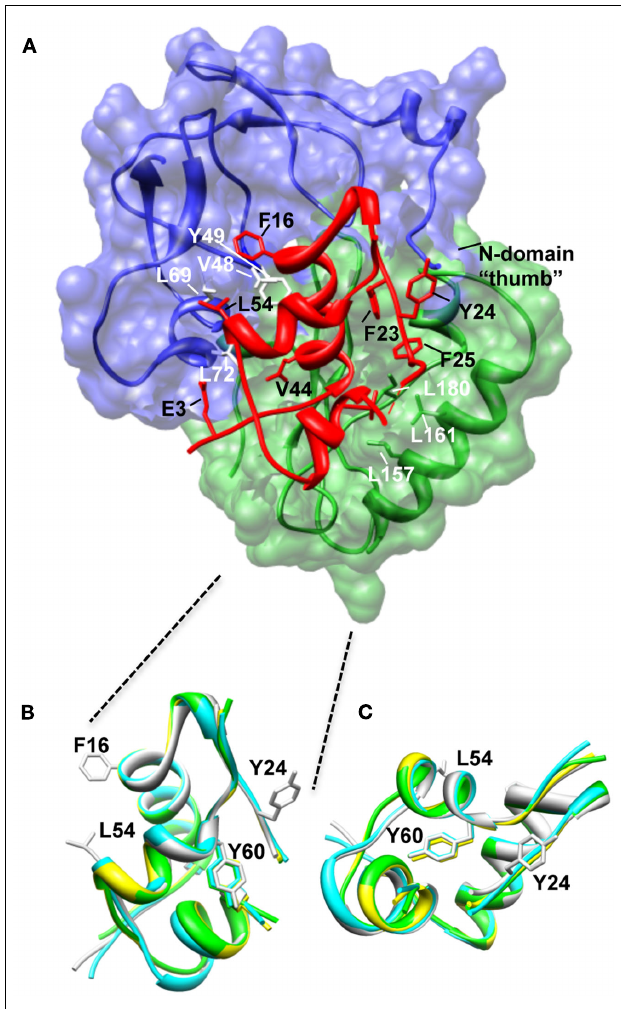
FIGURE 2 | Structure of the N-BP-4:IGF-I:C-BP-4 complex (PDB 2DSR; Sitar et al., 2006). (A) The N-domain of BP-4 (blue, residues 3–82) contacts the C-domain of BP-4 (green, residues 151–232) to form a high-affinity complex with IGF-I (red). IGF-I residues Phe16 and Leu54 insert into a cleft in the N-BP-4 encompassing residuesVal48,Tyr49, Leu69, and Leu72 (Kalus et al., 1998).The “thumb” region of the N-domain and residues Leu157, Leu161, and Ile180 of the IGFBP-4 C-domain are in contact with IGF-I residues Phe23,Tyr24, Phe25, andVal44, which are involved in IGF-1R binding, resulting in steric hindrance of IGF-I binding to the receptor (PDB 2DSR, Sitar et al., 2006). (B,C) Superposition of IGF-I crystal structures highlighting that theTyr60 side chain remains in the same position whether IGF-I is bound to IGFBPs or free. Ribbon views of IGF-I in the free form (bound to detergent molecules) PDB 1GZR (green; Brzozowski et al., 2002) and PDB 1IMX (yellow;Vajdos et al., 2001), the IGF-I‚mini-N-BP-5 binary complex (PDB 1H59, blue; Zeslawski et al., 2001), and the IGF-I‚N-BP-4‚C-BP-4 ternary complex (PDB 2DSR, light gray; Sitar et al., 2006) are superimposed over backbone heavy atoms of the three helices (Ala8–Cys18, Gly42–Cys48, Leu54–Cys61).The side chains of Phe16, Phe49, and Leu54 are shown.The structures are shown in two different orientations (B,C) .The structures in (B) are in an orientation equivalent to that of the IGF-I structure in (A) . Parts of the flexible regions (residues 1–2, 26–42, and 63–70) are excluded for clarity. Molecular graphic images were produced with the UCSF Chimera program from Resource for Biocomputing,Visualization, and Informatics at the University of